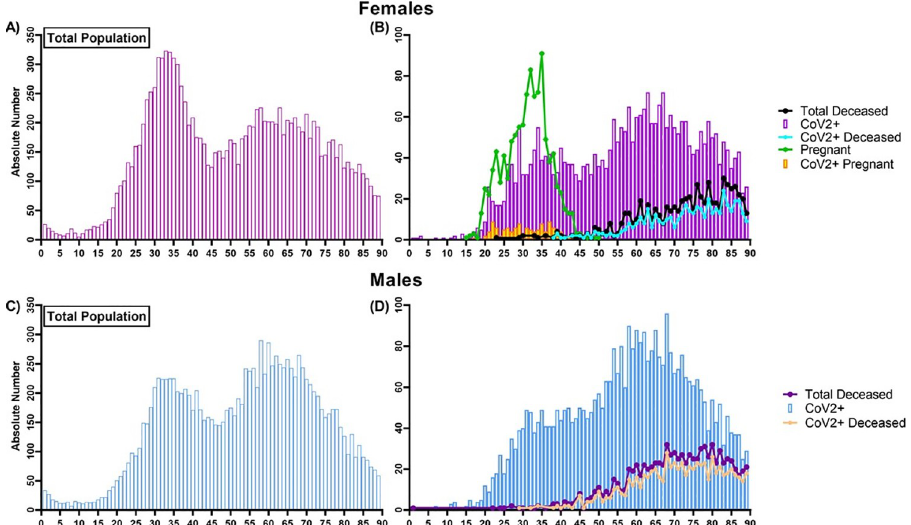
Fig 4. Distribution of Mount Sinai Health System patient cohort by age, sex, mortality, and CoV2 status. (A, C) In the Mount Sinai Health System cohort (n = 39,625) and the qRT-PCR confirmed or presumed positive CoV2 population; there is a bimodal nature of age distribution in both sexes when looking at the affected population. (B) Within the total female population, a large portion of the younger maxima [age = 31 years of age] represents females from labor and delivery (n = 1,068). Within the pregnant population, 10.8% of females tested positive for CoV2+, 85.2% tested negative. Unlike the total population, the age distribution in the deceased COVID-19 positive population is bell-curved skewed right towards the older population in both sexes with an average age of (B) 73 ± 12 years of age for females and (D) 71 ± 12 years of age for males. https://doi.org/10.1371/journal.pone.0254707.g004 age distribution of the total CoV2+ population is, although attenuated at first maxima, still bimodal for both sexes (Fig 4A–4C). For females, the two maxima occur around 33 and 61 years of age, while for males, the maxima occur at approximately 32 and 58 years of age (Fig 4A–4C). The average age for female patients was 58 ± 19, and for males, 57 ± 17 years of age (Table 5). Of note, within the total female population, a large portion of the younger maxima (31 years of age) represents females who presented for labor and delivery (n = 1,068) (Fig 4B, green line). Interestingly, in the total deceased population and deceased CoV2+ population, the age distribution in both sexes resembles a skewed bell curve shifted toward the older patient population with an average age of 73 ± 12 years of age for CoV2+ females and 71 ± 12 years of age for CoV2+ males, suggesting a small (2-year) but statistically significant difference in the average age of death from COVID-19 between males and females (p = 0.0022).